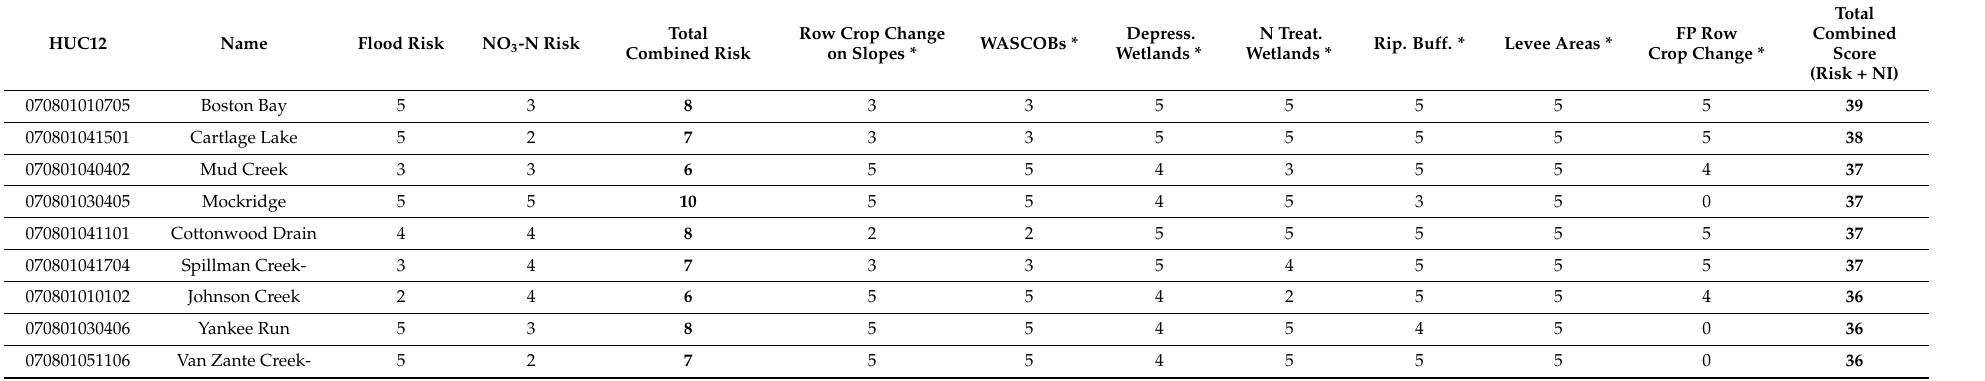
Table 2. Highest ranking watershed scores for HUC12 basins in Iowa-Cedar basin for combined flood and N risks and potential NI practice